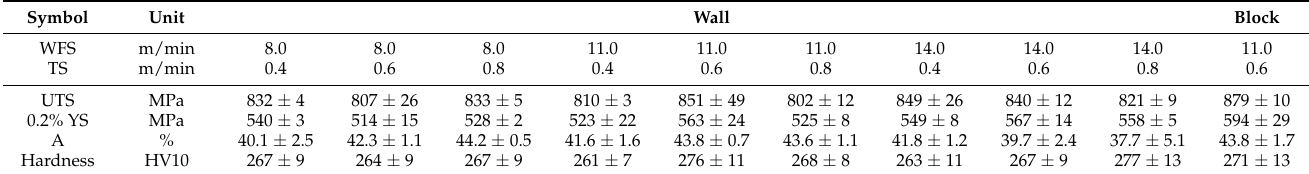
Table 5. Mechanical properties of wall and block parts of HY282 ( Φ 0.04 (cid:48)(cid:48) ) depending on arc energy.